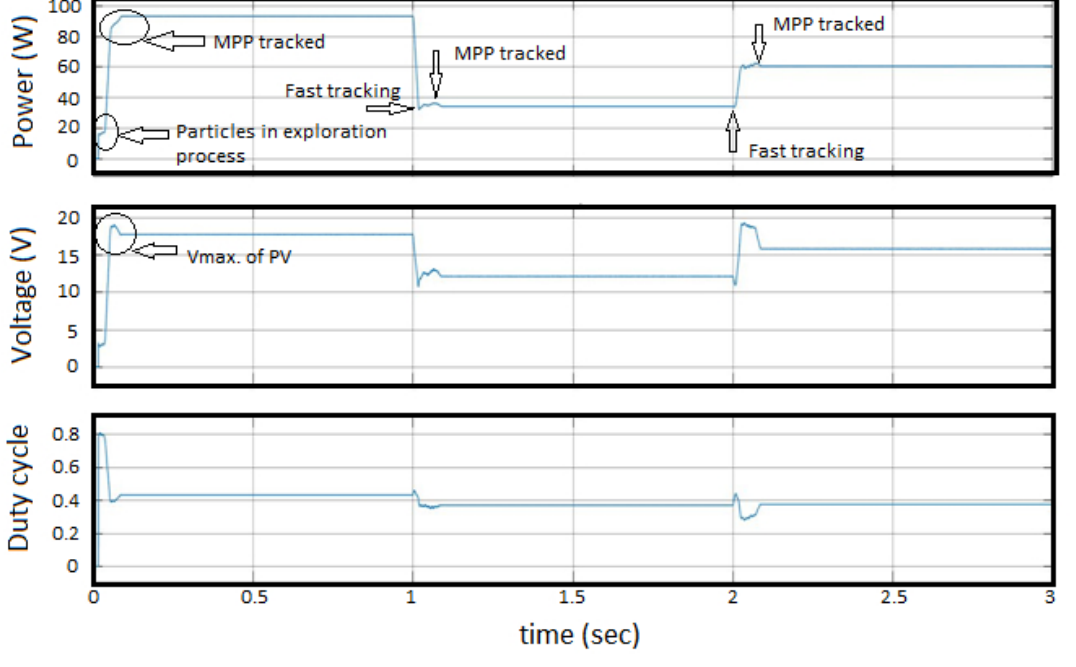
Figure 10. Duty cycle updation under different irradiance